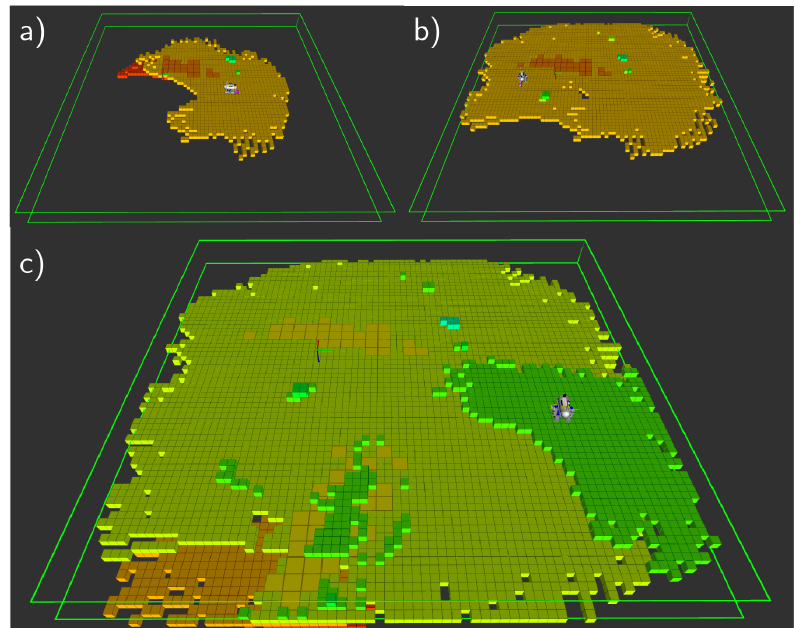
Figure 8. ( a – c ) show three different coverage steps during the autonomous mission performed with FeelHippo AUV. The autonomous planner was able to cover more than 90% of the target area. The two green polygons delimit the inspection area on the surface and at the maximum depth (four meters in this case). The data color indicates surface when green and turns to red as the depth